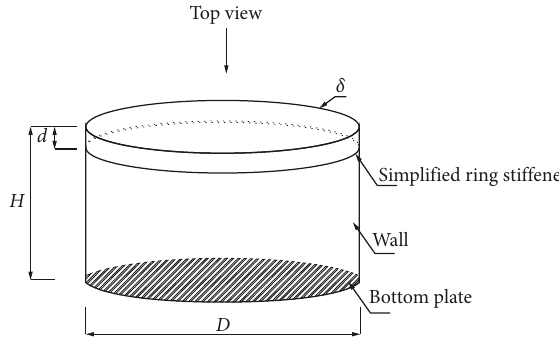
Figure 1: Configuration of the test Table 1: Dimension of the test specimen.